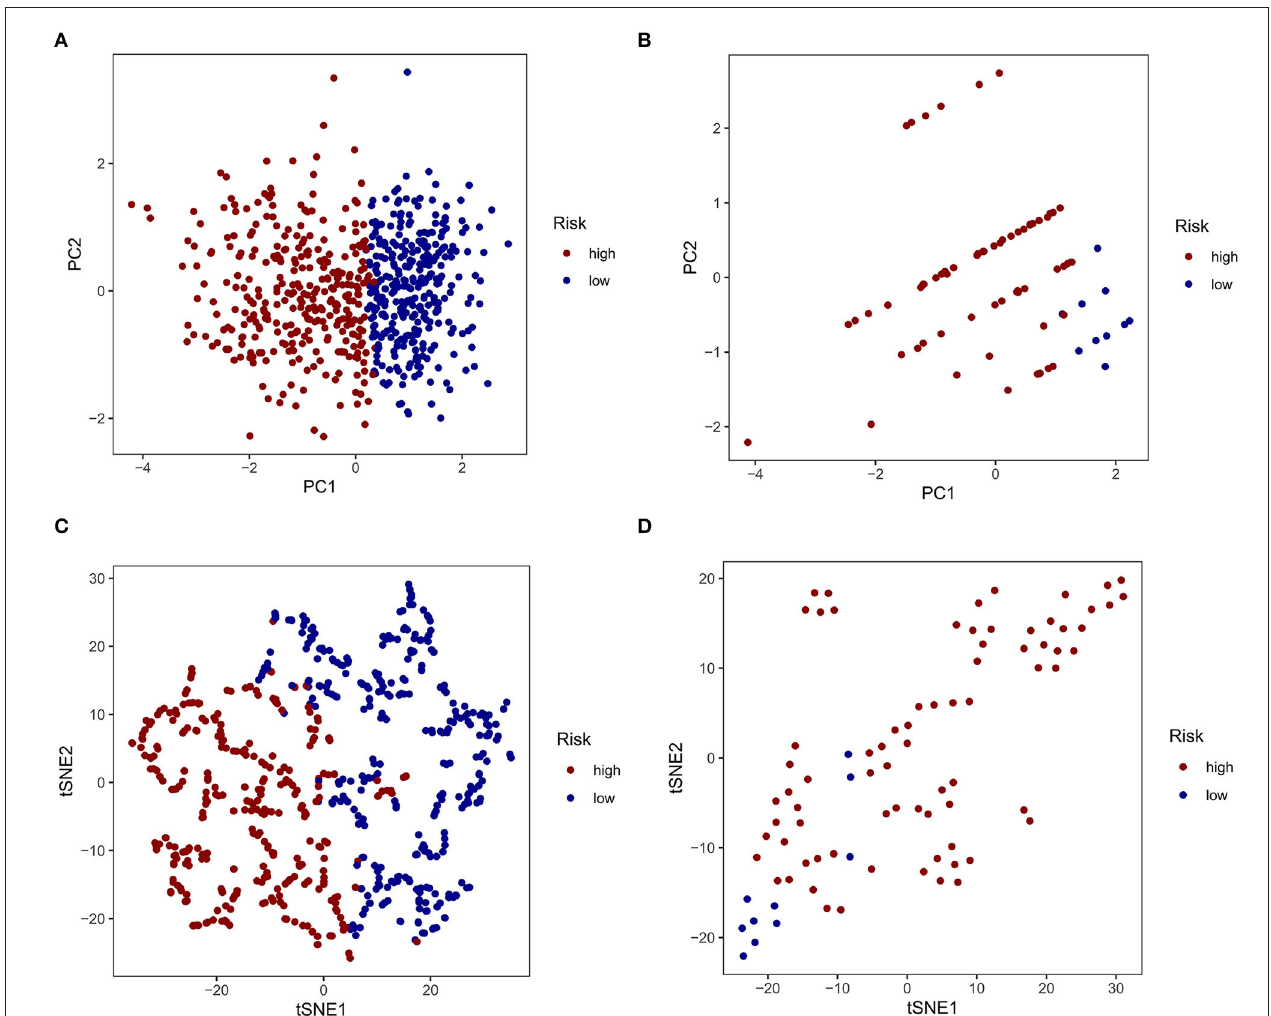
FIGURE 3 | Principal component analysis (PCA) and t-distributed stochastic neighbor embedding (t-SNE) analysis. (A, C) PCA and t-SNE analysis of Clusters 1 and 2 from the TCGA database. (B, D) PCA and t-SNE analysis of Clusters 1 and 2 from the GEO